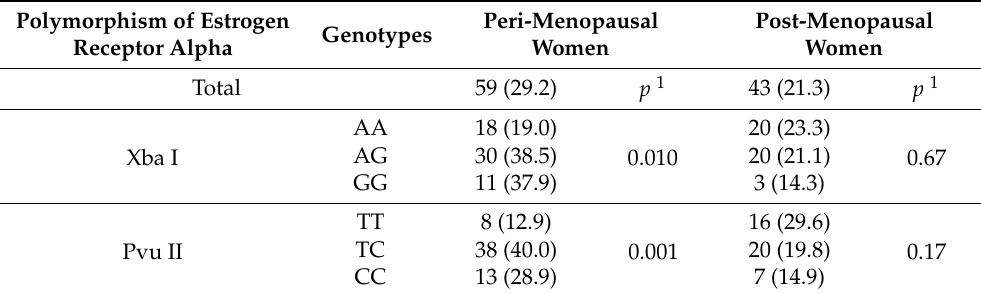
Table 2. Prevalence of metabolic syndrome in peri- and post-menopausal women in total and by polymorphism of estrogen receptor alpha: Xba I and Pvu